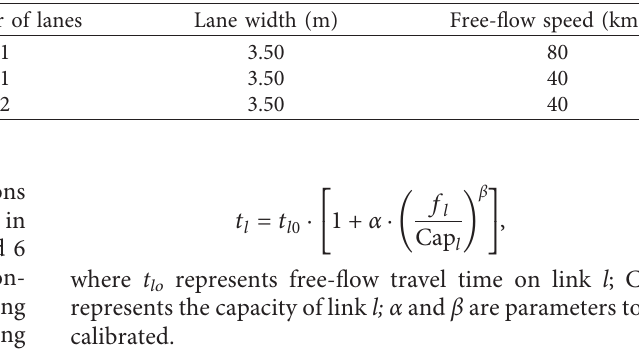
Figure 4: Test networks: (a) single-link framework and (b) double-link framework. Table 1: Network